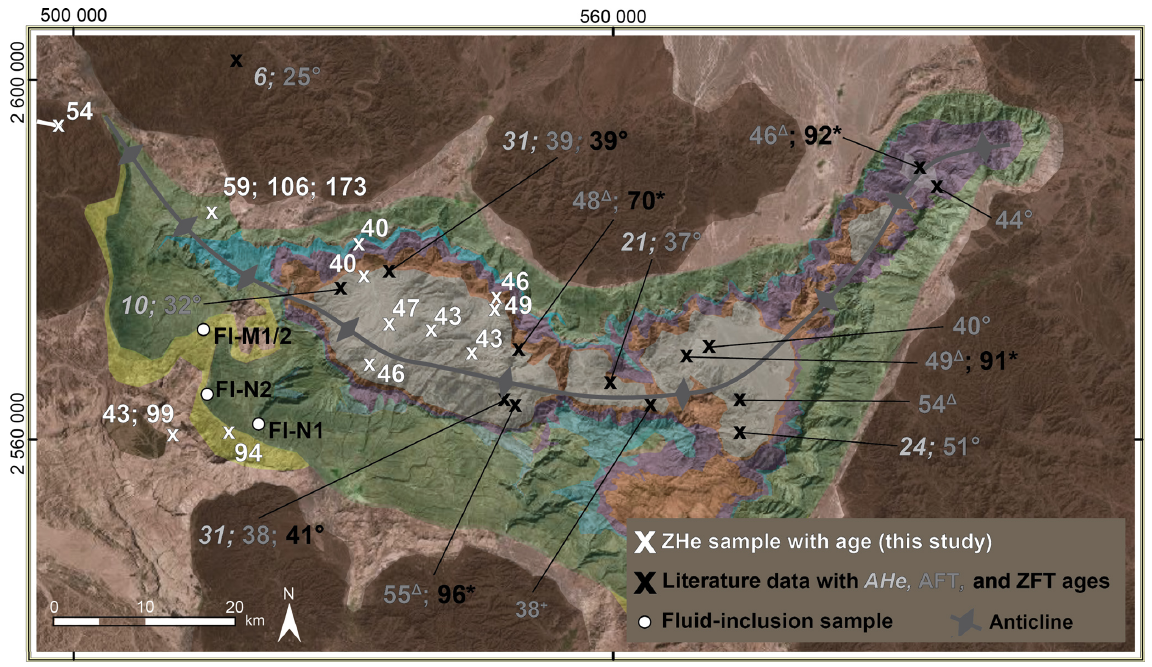
Figure 4. Map view of ZHe ages (in Ma). Data outline a general cooling between 58 . 9 ± 7 . 0 and 39 . 8 ± 3 . 0Ma. Some samples outside of the dome show two age clusters, with an additional age of ca. 100Ma. Additional temperature data refer to zircon fission track ages from (*) Saddiqi et al. (2006), apatite fission track ages from ( (cid:49) ) Poupeau et al. (1998) and (+) Mount et al. (1998), and AHe, AFT, and ZFT ages from ( ◦ , gray) Hansman et al. (2017). Moreover, the locations of samples used for fluid-inclusion measurements are shown. Colors in the background depict geological units (brown: ophiolite, pink: Hawasina units, light green: Muti Fm., dark green: Wasia and Kahmah Gp., blue: Sahtan Gp., purple: Mahil Fm., orange: Saiq Fm., gray: pre-Permian, shaded DEM from Esri, Digital Globe, swisstopo, and the GIS user